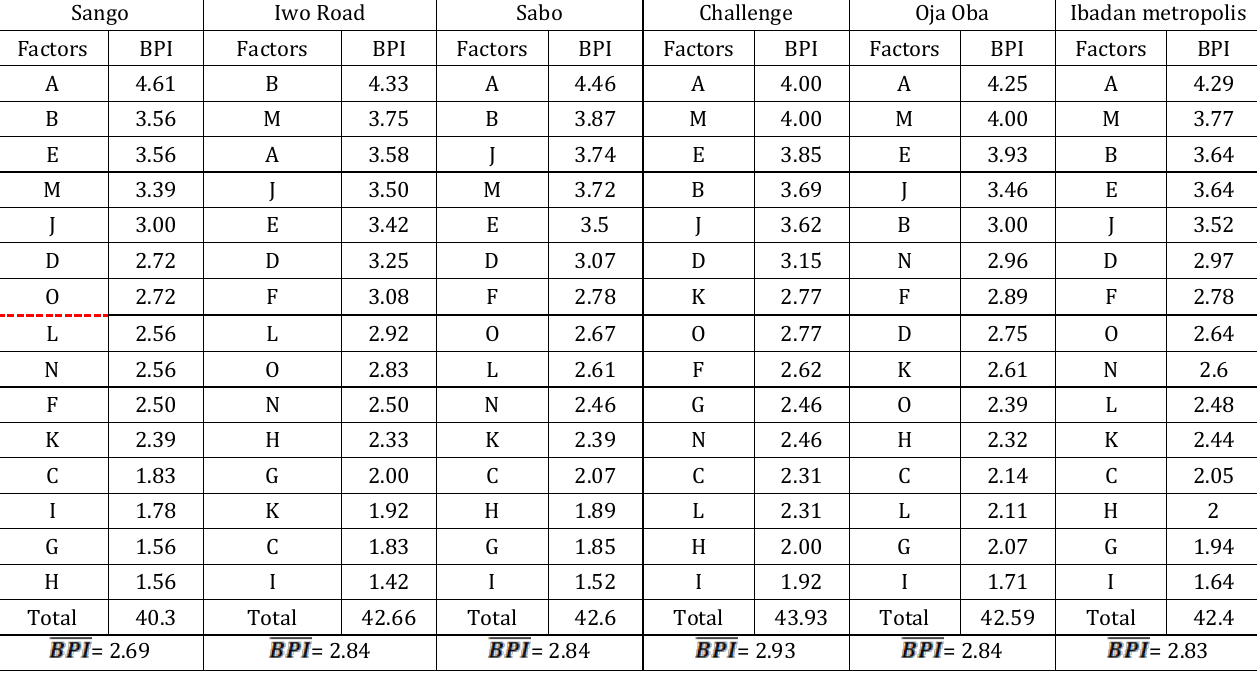
Table 2. Beggars’ Perception Index on the determinants of begging prevalence in Ibadan metropolis Sango Iwo Road Sabo Challenge Oja Oba Ibadan metropolis Factors BPI Factors BPI Factors BPI Factors BPI